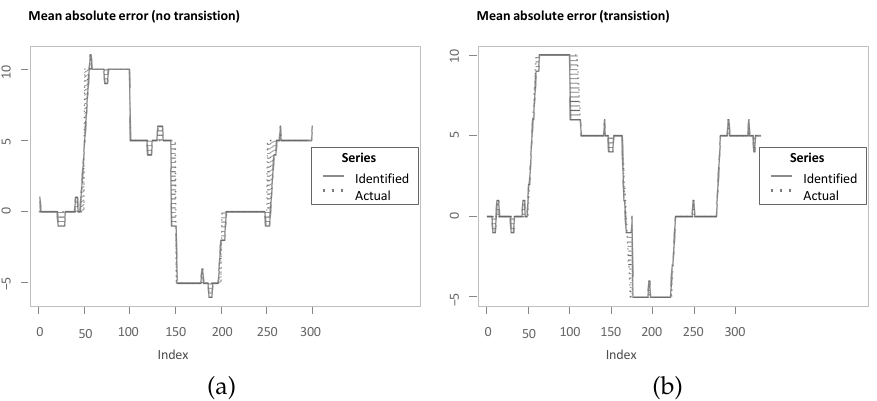
Figure 10. ( a ) Mean absolute error (MAE) without transition between different regimes; ( b ) mean absolute error (MAE) with transition between different